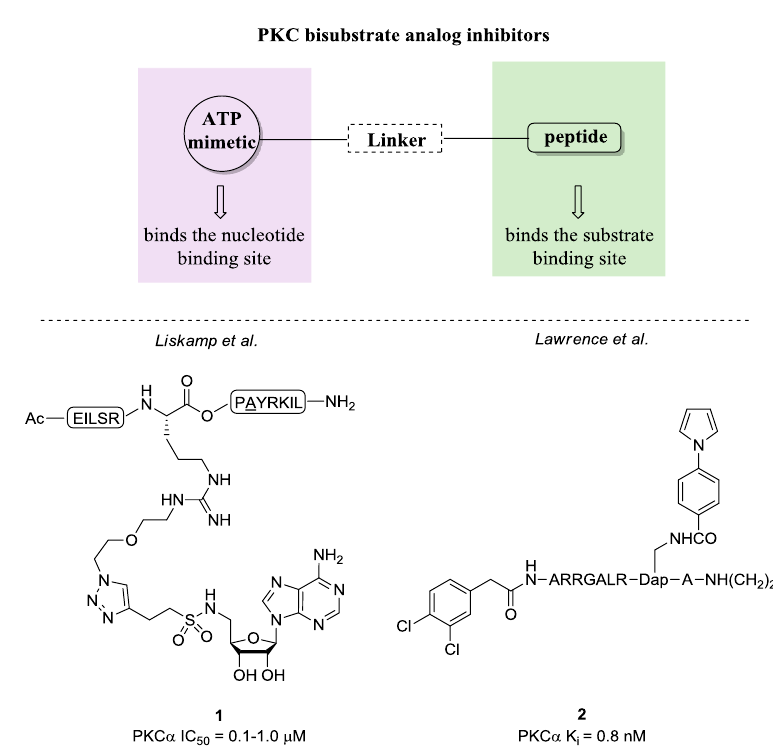
Figure 6. Bisubstrate analog inhibitors.